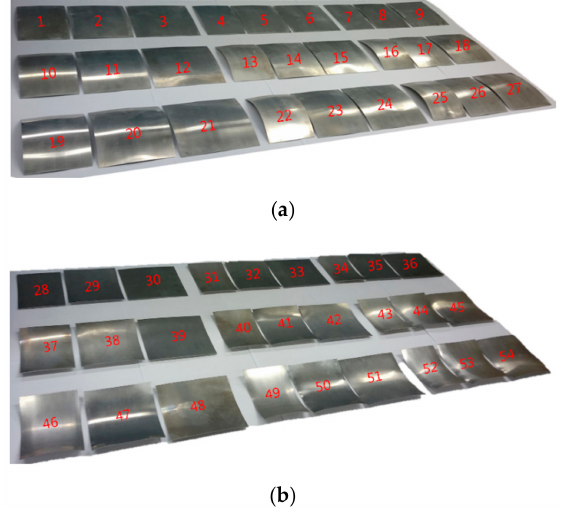
Figure 5. Results of the experiment using the FRRF apparatus. ( a ) Convex shape and ( b ) saddle